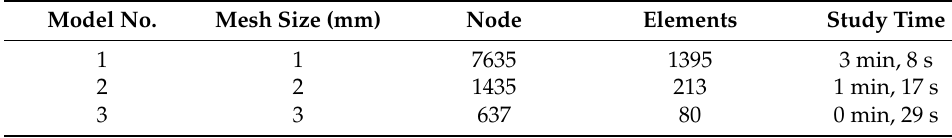
Table 2. FE solution information against different mesh